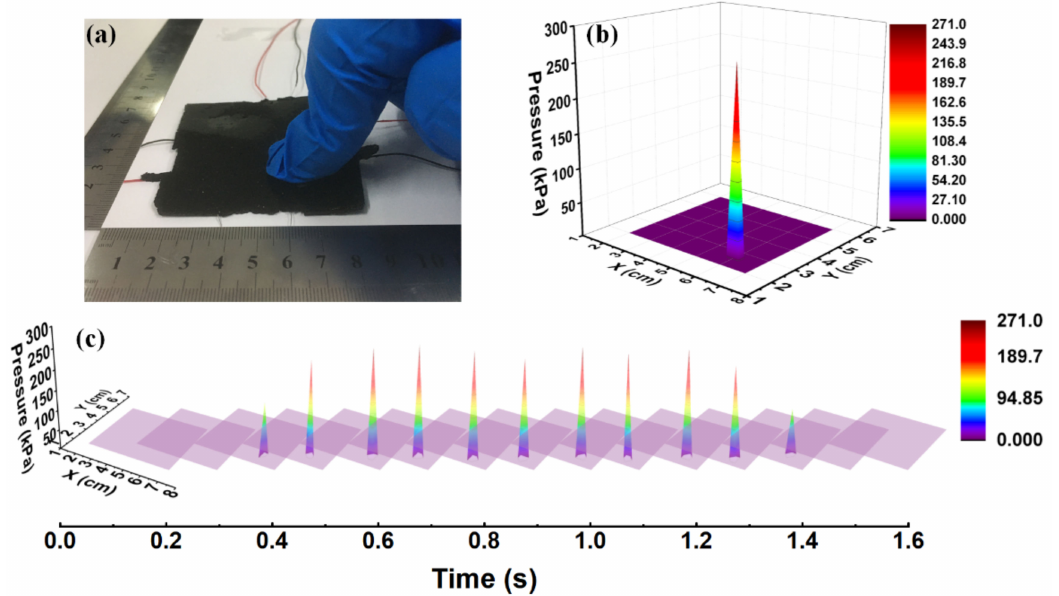
Figure 10. ( a ) The sample was pressed at the lower-right corner, ( b ) the 3D mapping of the pressing pressure and location, and ( c ) the dynamic display of the process of one cycle of pressing within ~1.5